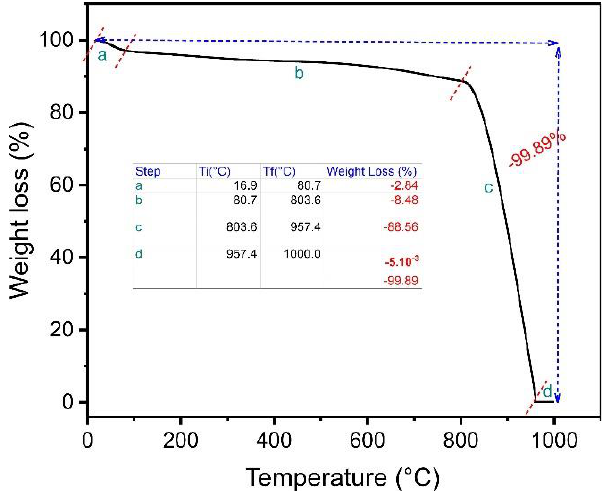
Figure 2. Thermogravimetric analysis of ABC biochar.